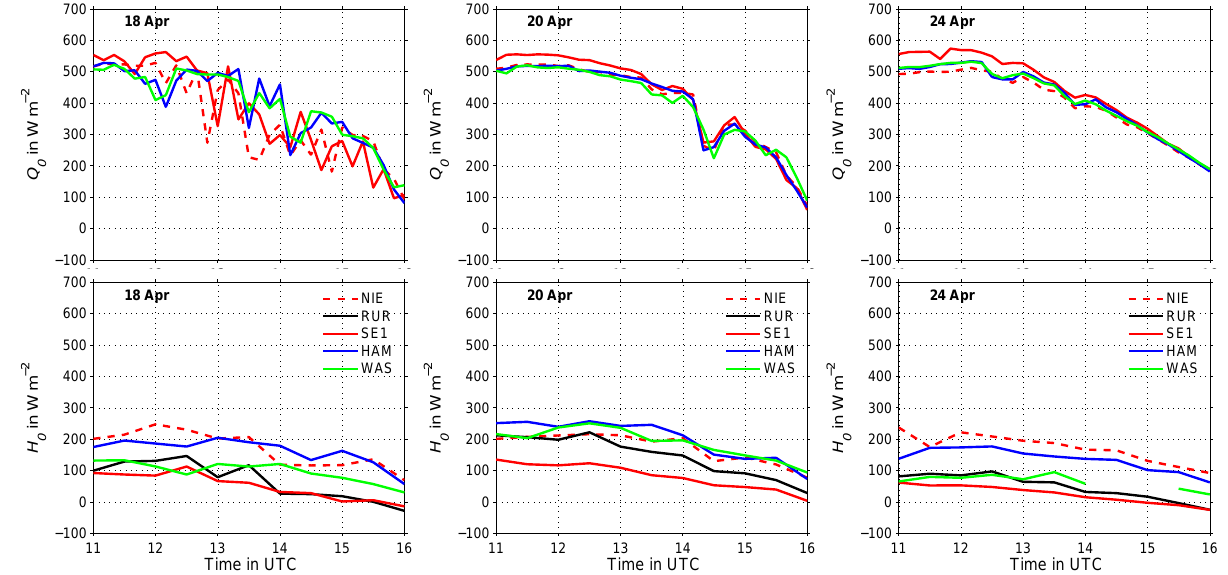
Figure 12. Net radiation ( Q 0 , upper row) and surface sensible heat flux ( H 0 ) at the five energy balance stations (NIE – Niederzier; RUR – Ruraue; SE1 – Selhausen; HAM – Hambach; WAS – Wasserwerk; cf. Fig. 1) for 3 days with significant spatial differences of vertical velocity